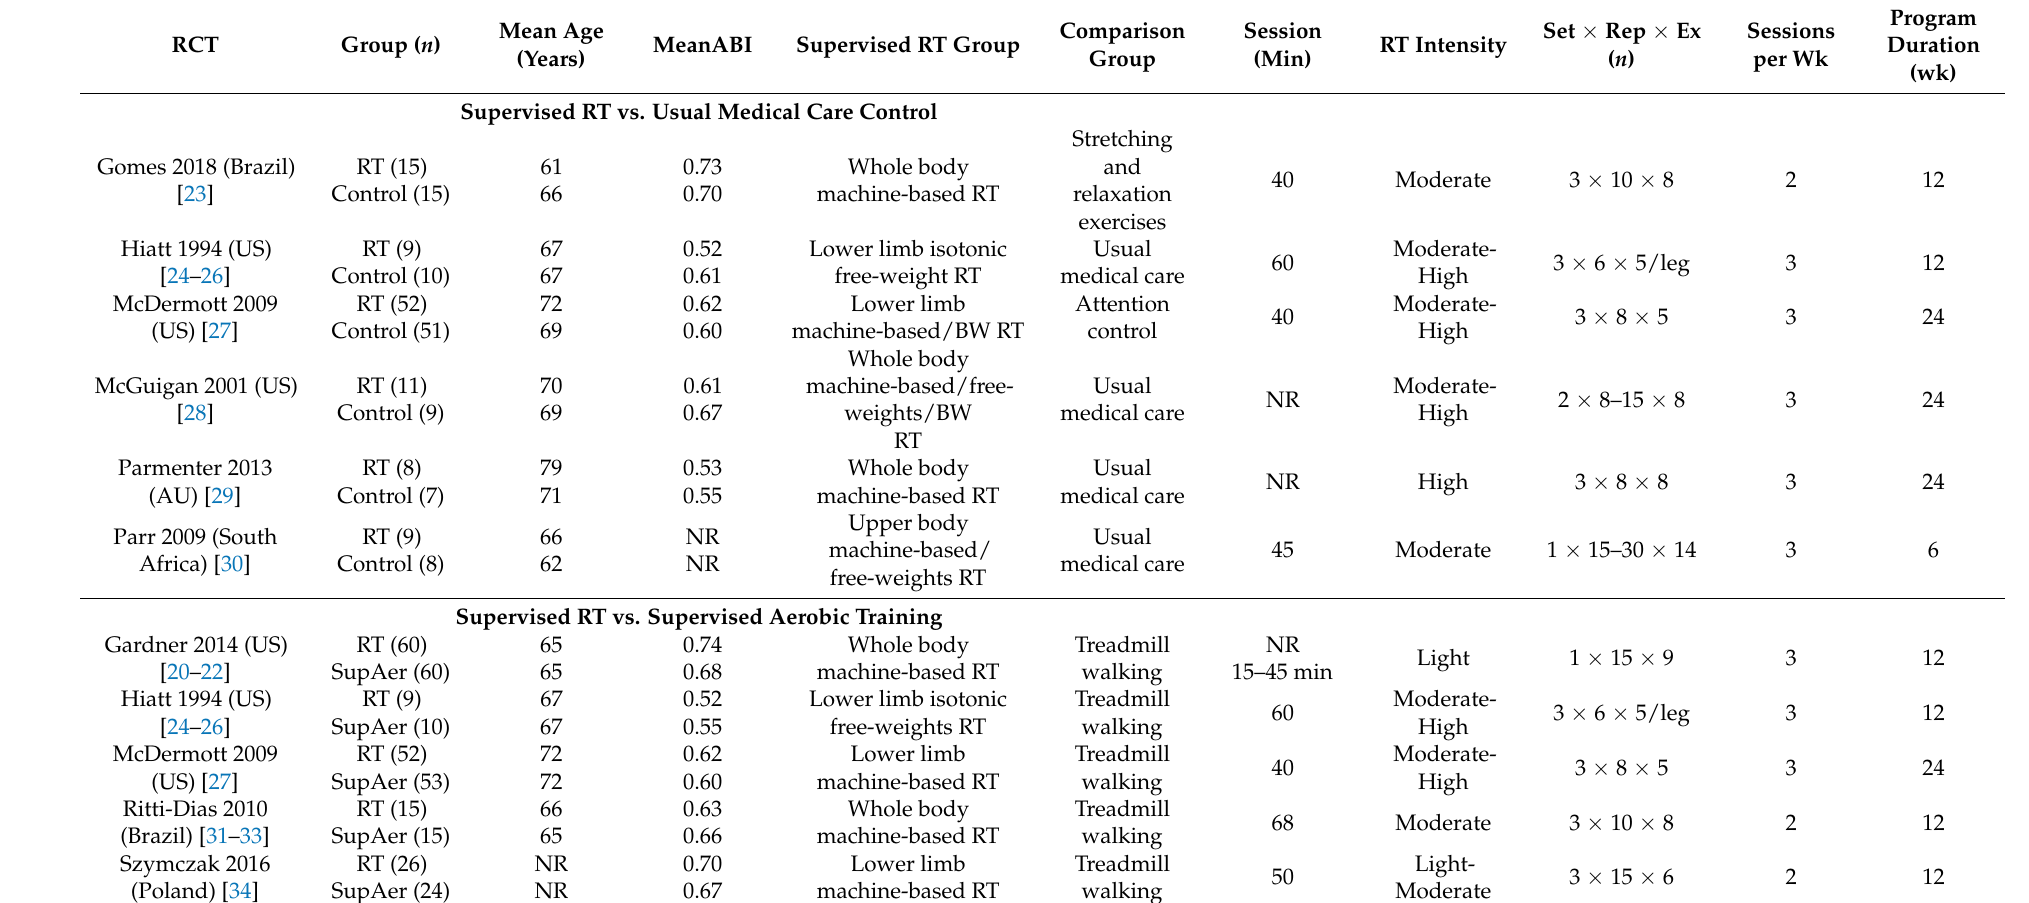
Table 1. Characteristics of the RCTs included in this systematic review and